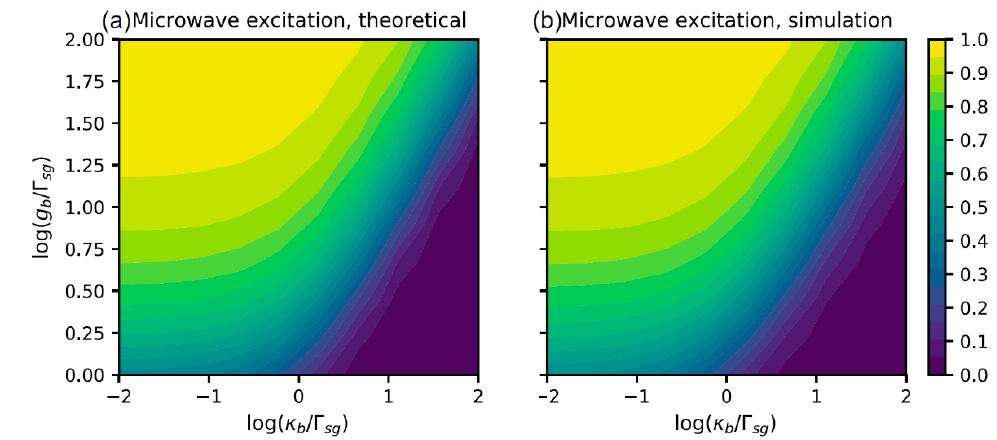
Figure 2. Dependence of state | s (cid:105) population on the cavity decay rate and coupling constant; ( a ) theoretical result, based on Equation (7); ( b ) simulation result, using the scheme in Figure 1. t , a probe laser resonance with the optical cavity ( At 1 2